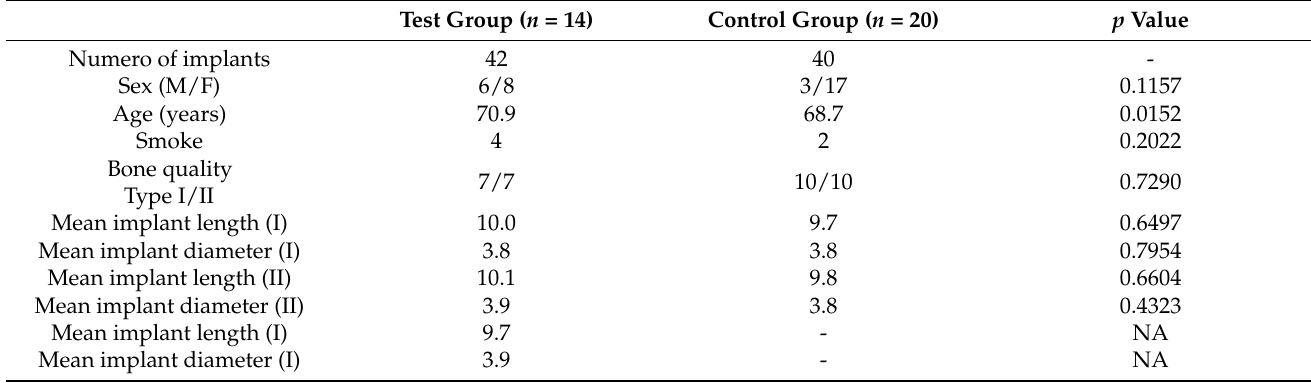
Table 1. Main patients and implants characteristics.